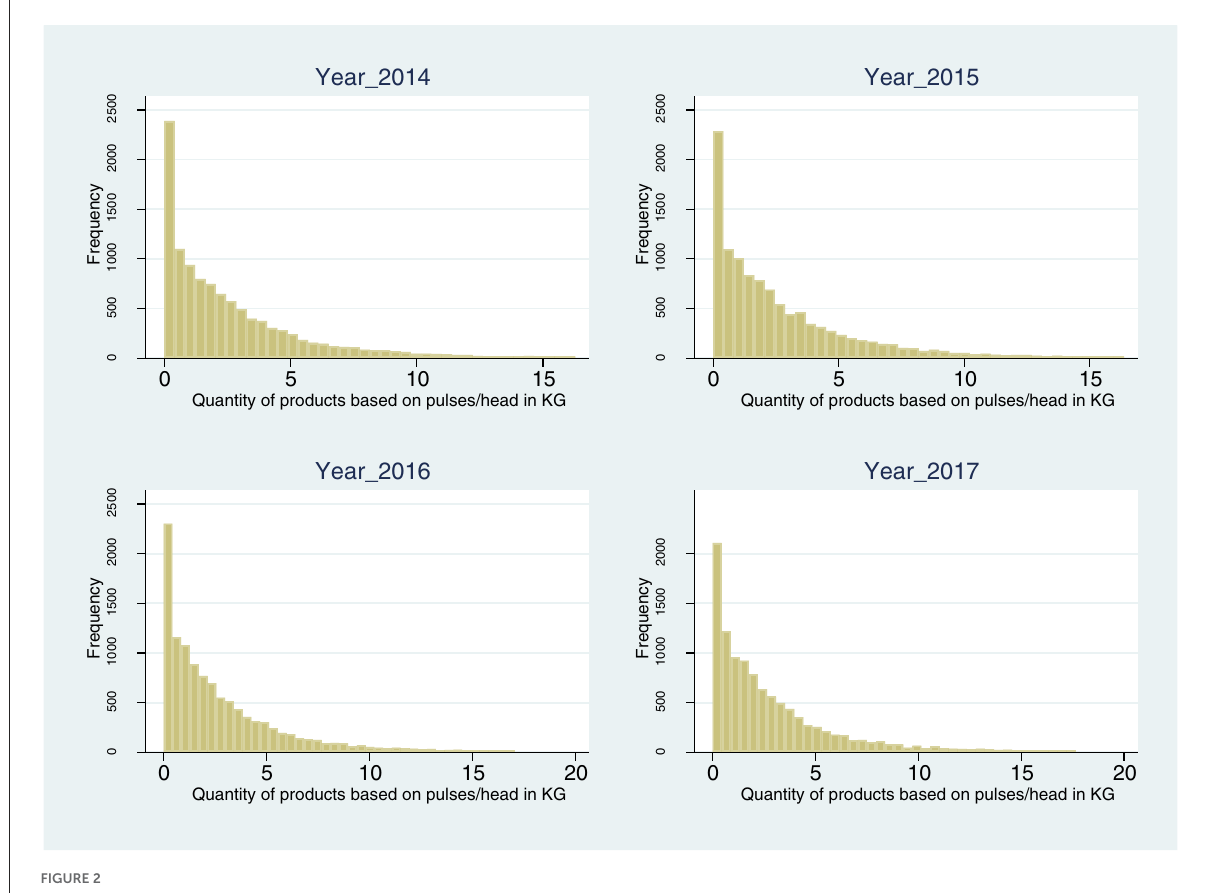
FIGURE2 Proportion of zero purchases in the sample 2014–2015. Source: Kantar Worldpanel